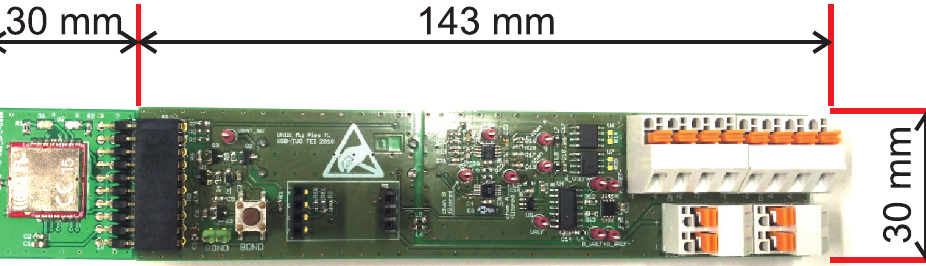
Figure 5. Load anchor cell wireless node developed by the authors, with an IQRF R (cid:13)